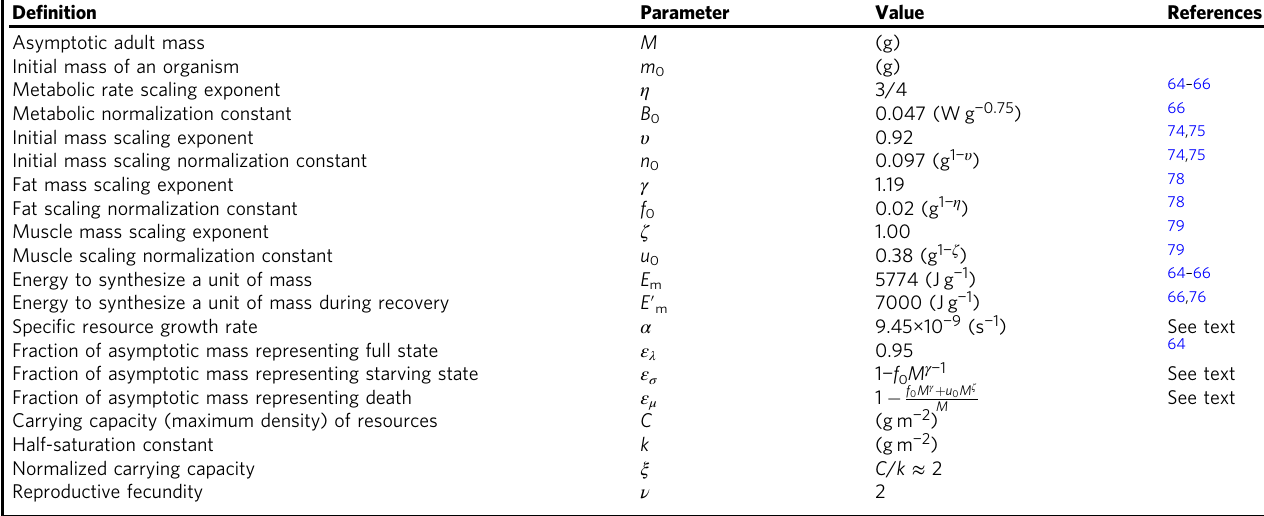
Table 1 Parameter values for